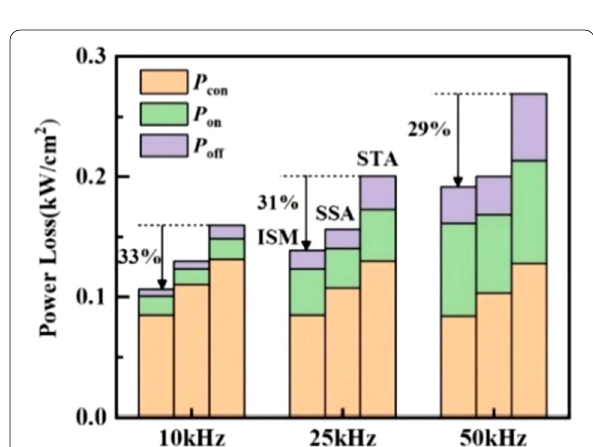
Fig. 12 Power losses under different switching frequencies of the ISM RC-LIGBT, STA and SSA LIGBT at J L